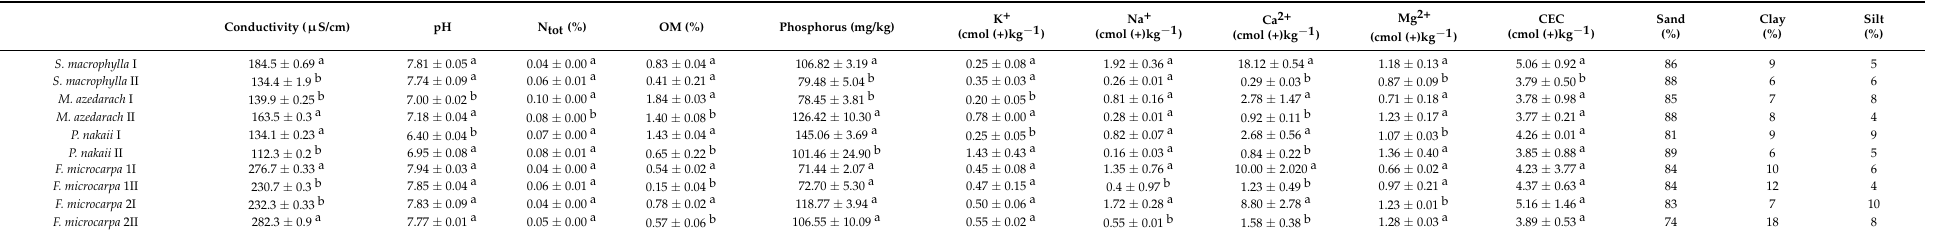
Table 3. Physicochemical properties of the soil of the urban tree species including Swietenia macrophylla , Melia azedarach , Podocarpus nakaii , and Ficus microcarpa responding to the amendment with biochar/compost in